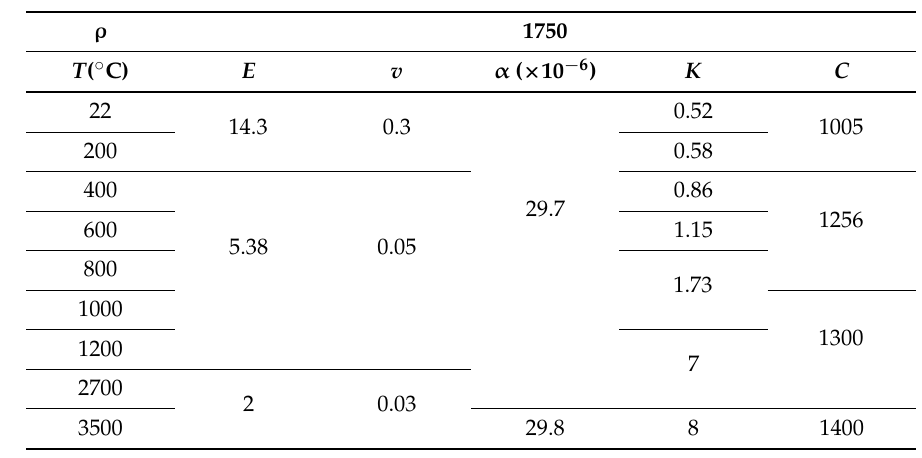
Table 4. Material properties of silica-phenolic-resin.